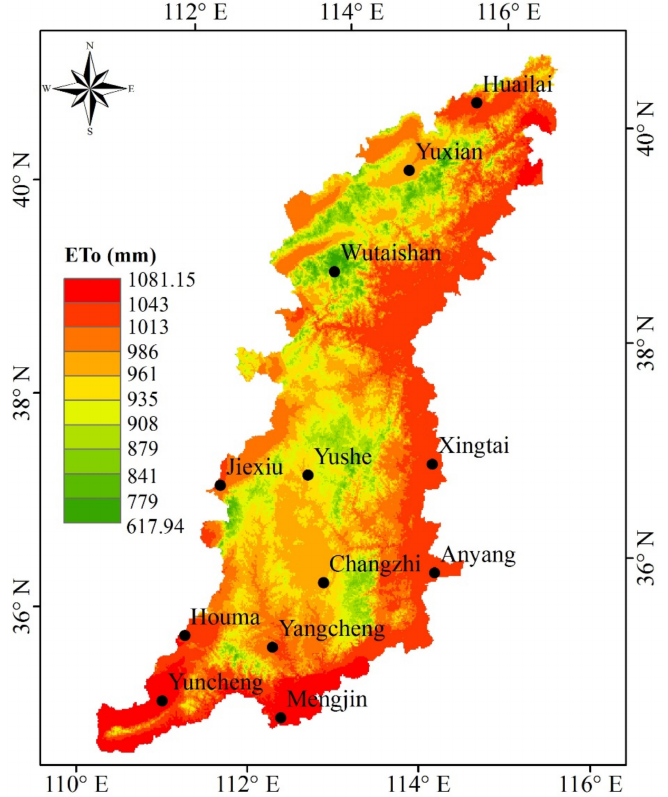
Figure 2. The spatial distribution of 44-year annual average ETo in the THM.